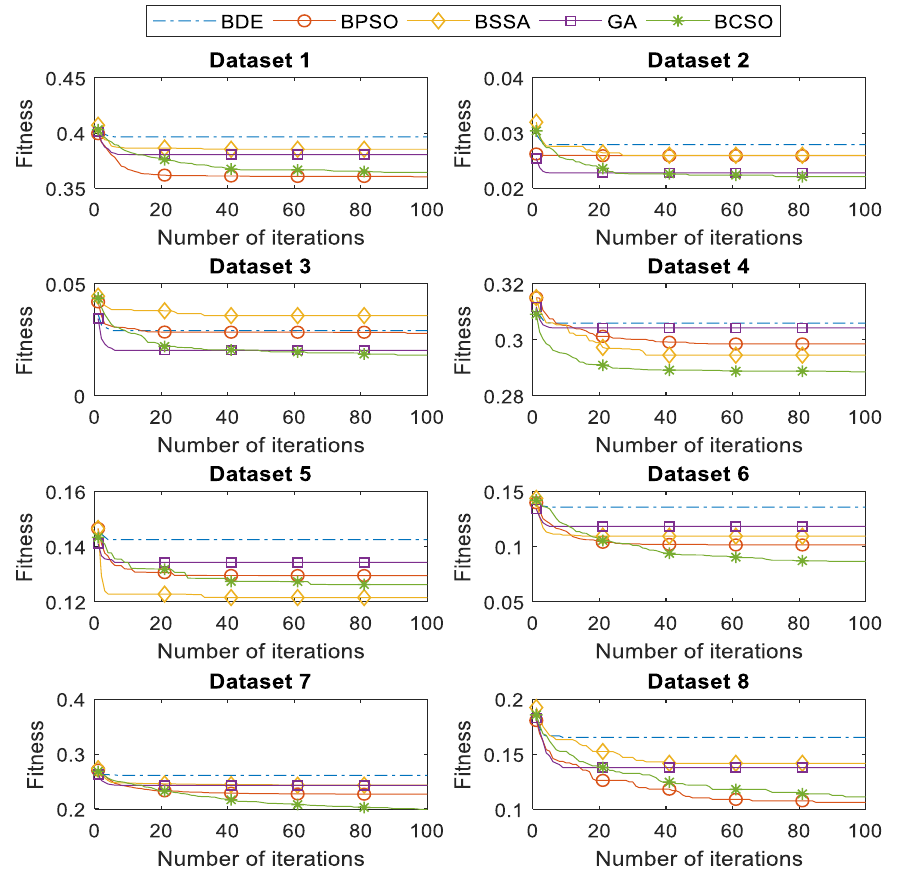
Figure 5. Convergence curves of BDE, BPSO, BSSA, GA, and BCSO on datasets 1 – 8.